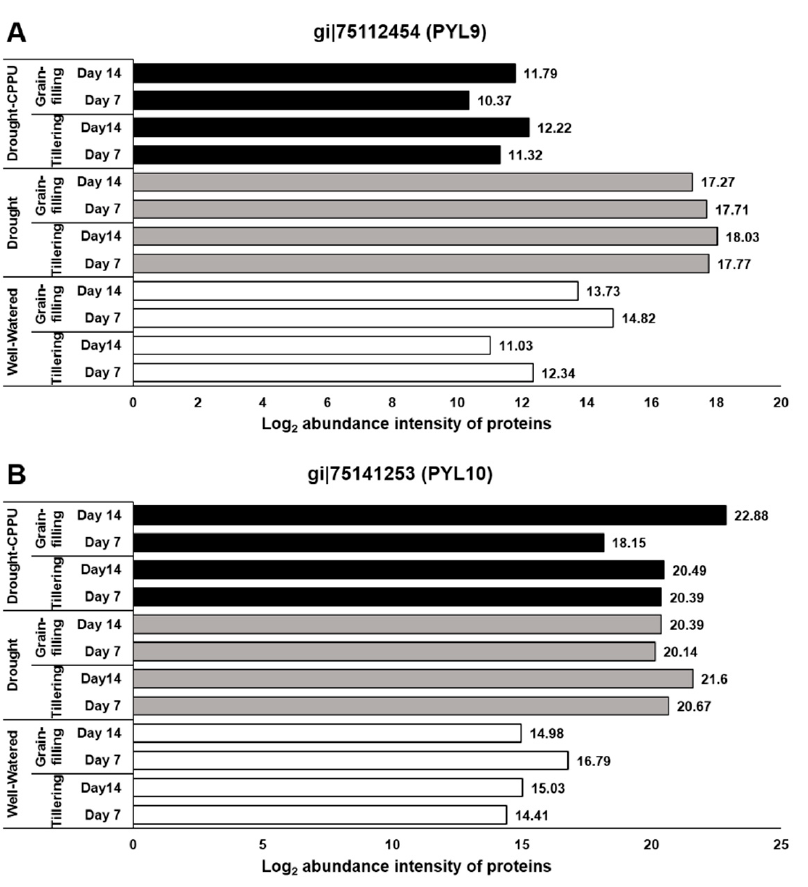
Figure 3. The influence of synthetic cytokinin and drought on the abundance intensities of PYL9 ( A ) and PYL10 ( B ) proteins, implicated in ABA reception and stomatal conductance, at the tillering and grain-filling stages of the rice. Protein abundance intensities, represented on the X- axis, are the highest log2 fold change values of technical replicates. [Well-Watered plants were maintained at a soil moisture tension of − 15 kPa during the treatment period. Drought stress was imposed by withholding water for up to 14 days. Soil moisture tensions of − 55 kPa and − 72 kPa were recorded at day 7 and day 14 during the treatment, respectively. CPPU treatment was given by foliar spraying plants with a 5 mg / L solution of CPPU at the rate of 25 mL / plant on day 6 of drought